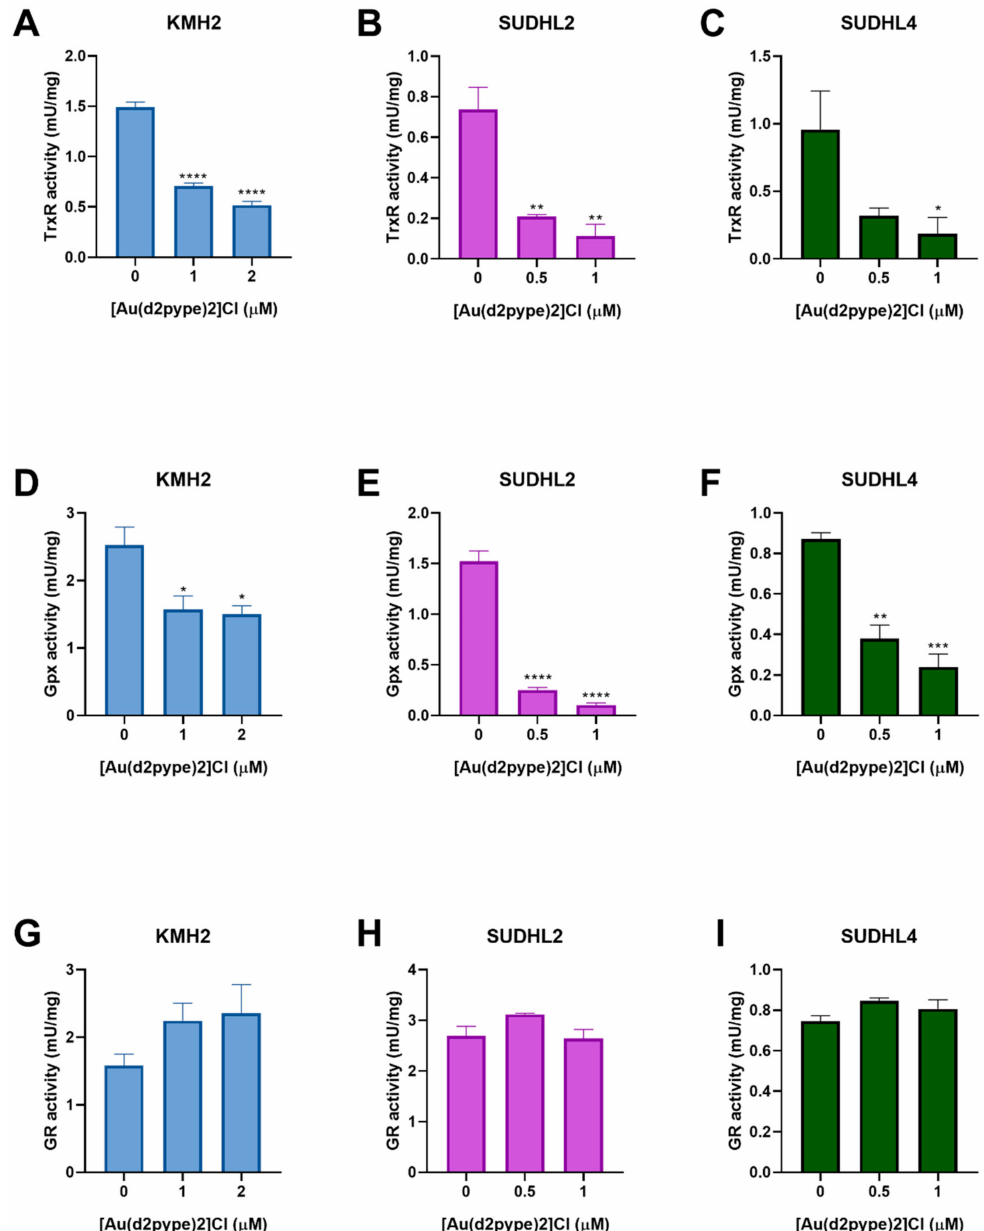
Figure 3. [Au(d2pype)2]Cl inhibits the selenoprotein activity in lymphoma cells. KMH2, SUDHL2, and SUDHL4 cells were treated with the indicated concentrations of [Au(d2pype)2]Cl for 24 h. Protein lysates were prepared and TrxR activity ( A – C ), Gpx activity ( D – F ), GR activity ( G – I ) was measured. Results were analysed by one-way ANOVA using Dunnett’s post-test. Values indicate mean ± SEM ( n = 3). * p < 0.05, ** p < 0.01, *** p < 0.001, **** p < 0.0001. Glutathione peroxidase (Gpx) and glutathione reductase (GR) are members of the GSH system. Gpx activity assays showed that [Au(d2pype)2]Cl can also inhibit Gpx activity in lymphoma cell lines. In KMH2 cells, treatment with 1 µ M [Au(d2pype)2]Cl led to a significant inhibition of Gpx activity (Figure 3D). In SUDHL2 and SUDHL4 cells,